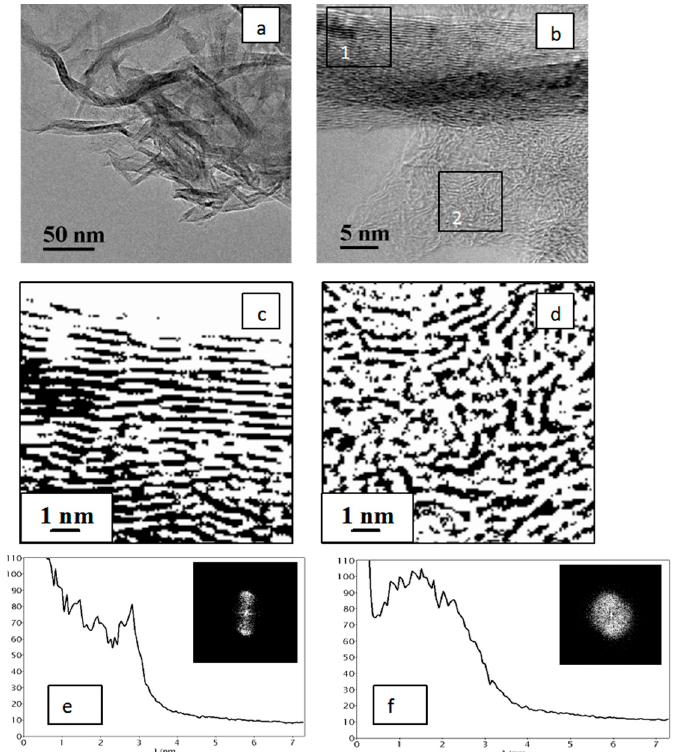
Figure 5. TEM images of PCCNC obtained using the GO additive ( a , b ); fragments of the TEM image ( b ) in the binary form (marked by squares): fragment 1 ( c ) and fragment 2 ( d ); RCIP obtained by processing the FFT images displayed in the insets ( e , f ) (units on the x axis correspond to the inverse distance between graphene layers, 1/nm).